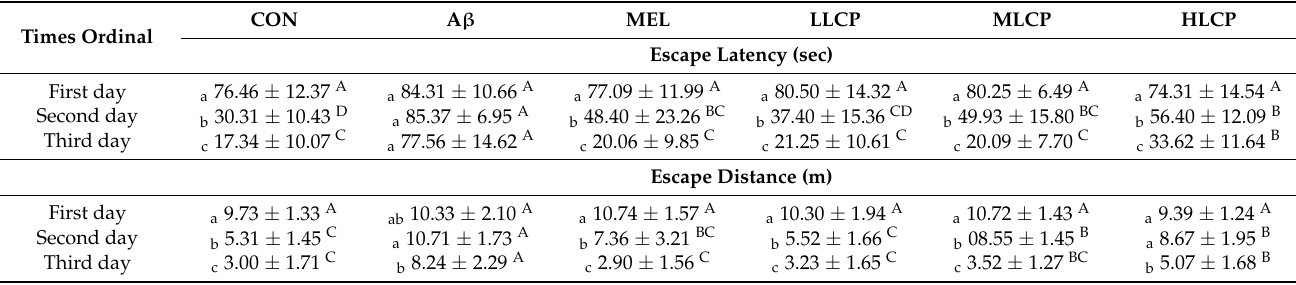
Table 2. Effects of Listea cubeba Persoon fruit powder on escape time and distance of the reference memory task in A β -induced Alzheimer’s mice.